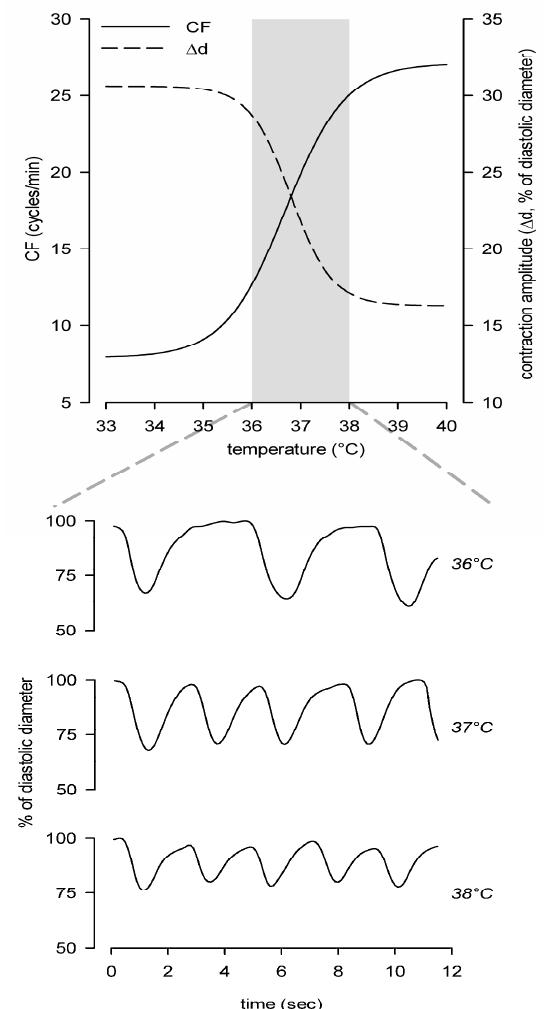
Figure 3. Temperature-dependent modulation of diaphragmatic lymphatics contractility, affecting both CF and contraction amplitude ( Δ d). Upper panel: positive chronotropic effect on CF (solid line) and negative inotropic effect on Δ d (dashed line). Gray area highlights the range of steepest variation of both parameters. Lower panel shows representative traces of vessel diameter over time recorded in the range of 36–38 °C. Data taken from [94].